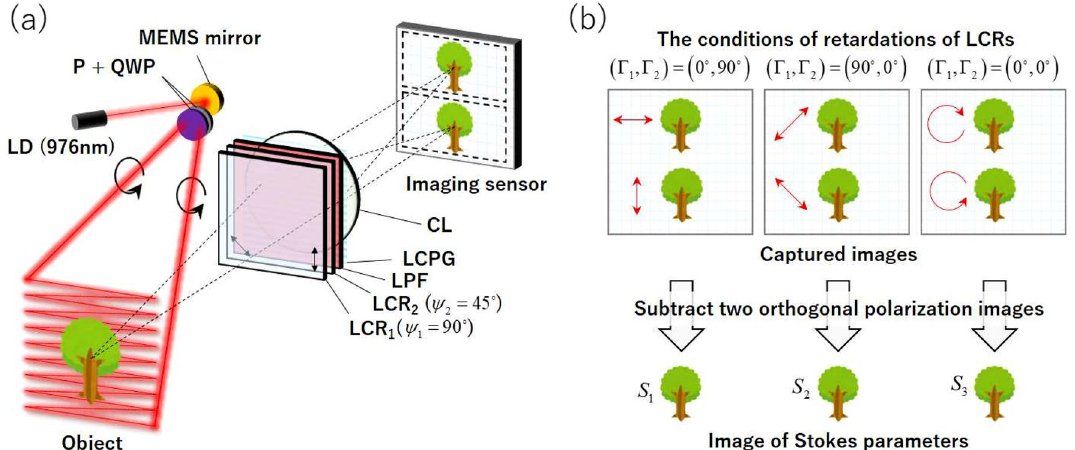
Figure 2. ( a ) Schematic of the PPPI system using the liquid crystal polarization grating (LCPG). The PPPI system consists of a polarization generator and a polarization analyzer. The polarization projector is assembled from the near-infrared-laser diode (NIR-LD), the micro-electro-mechanical systems (MEMS) mirror, the polarizer (P), and the quarter-wave plate (QWP). The polarization camera is assembled from the liquid crystal retarders (LCR 1 and LCR 2 ), the long-pass filter (LPF), the LCPG, the camera lens (CL), and the imaging sensor. The ψ 1 and ψ 2 are the orientation angles of fast axis of LCRs. ( b ) Principle of PI using the LCPG and two LCRs.